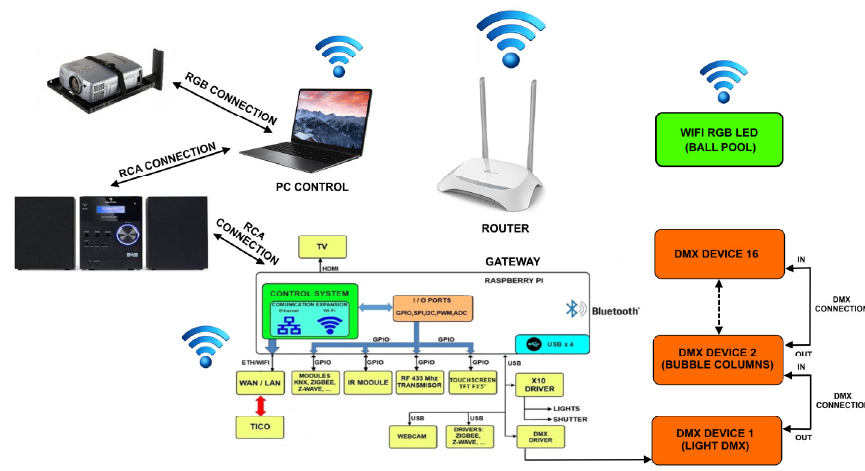
Figure 20. Communication scheme for context anticipation service.